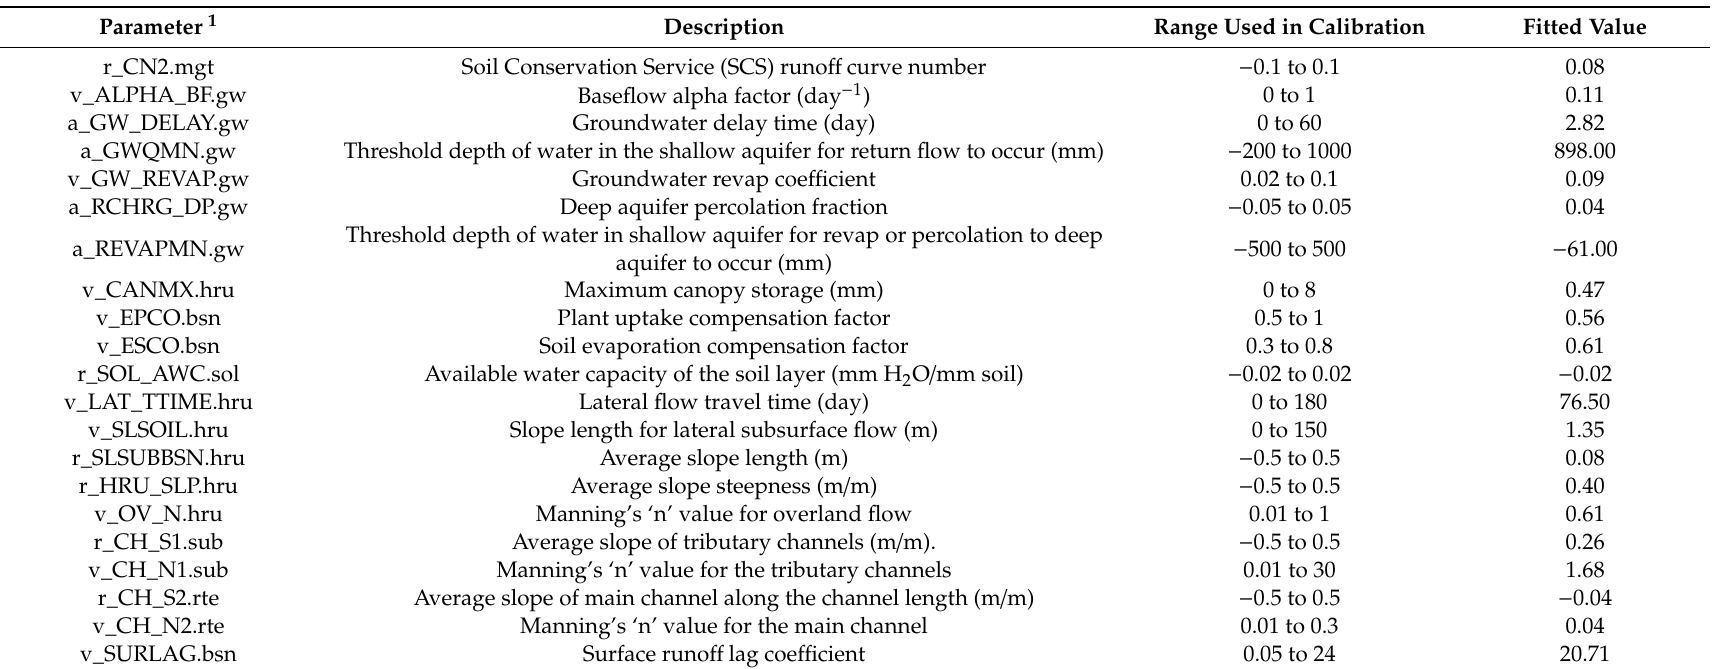
Table 5. Description of parameters used for SWAT model calibration in the